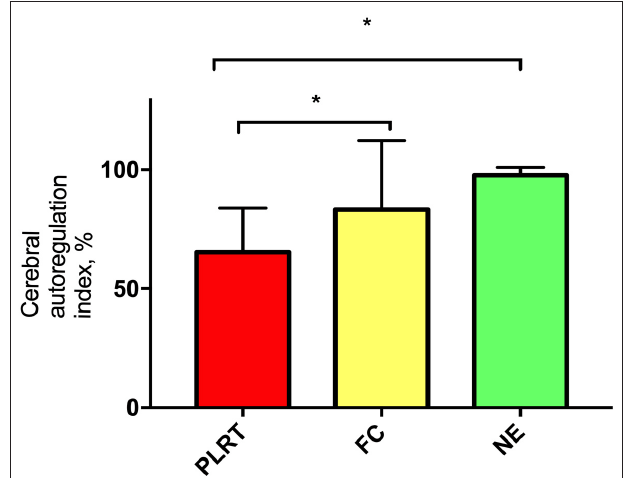
FIGURE 1 | Percentage of cerebral autoregulation index. Data are expressed as mean, standard deviation. PLRT, passive leg raising test; FC, fluid challenge; NE,